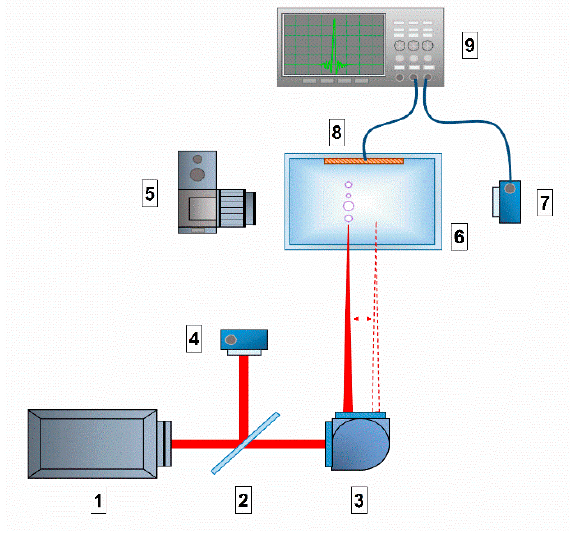
Figure 10. Schematic representation of the experimental setup: 1. laser source; 2. mirror; 3. Galvano-mechanical system of mirrors; 4. pin photodiode; 5. digital camera; 6. glass cell with solution; 7. pin photodiode; 8. acoustic membrane; 9. digital oscilloscope.